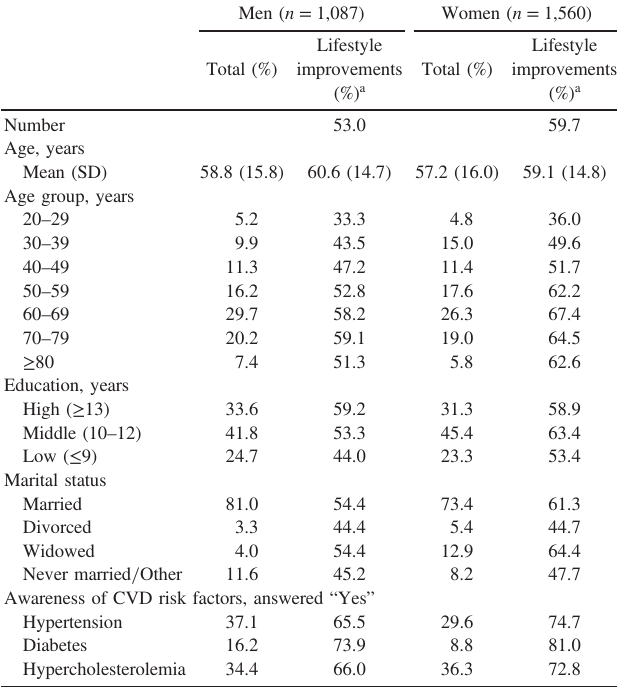
Table 1. Characteristics of participants: NIPPON DATA2010 ( n = 2,647)